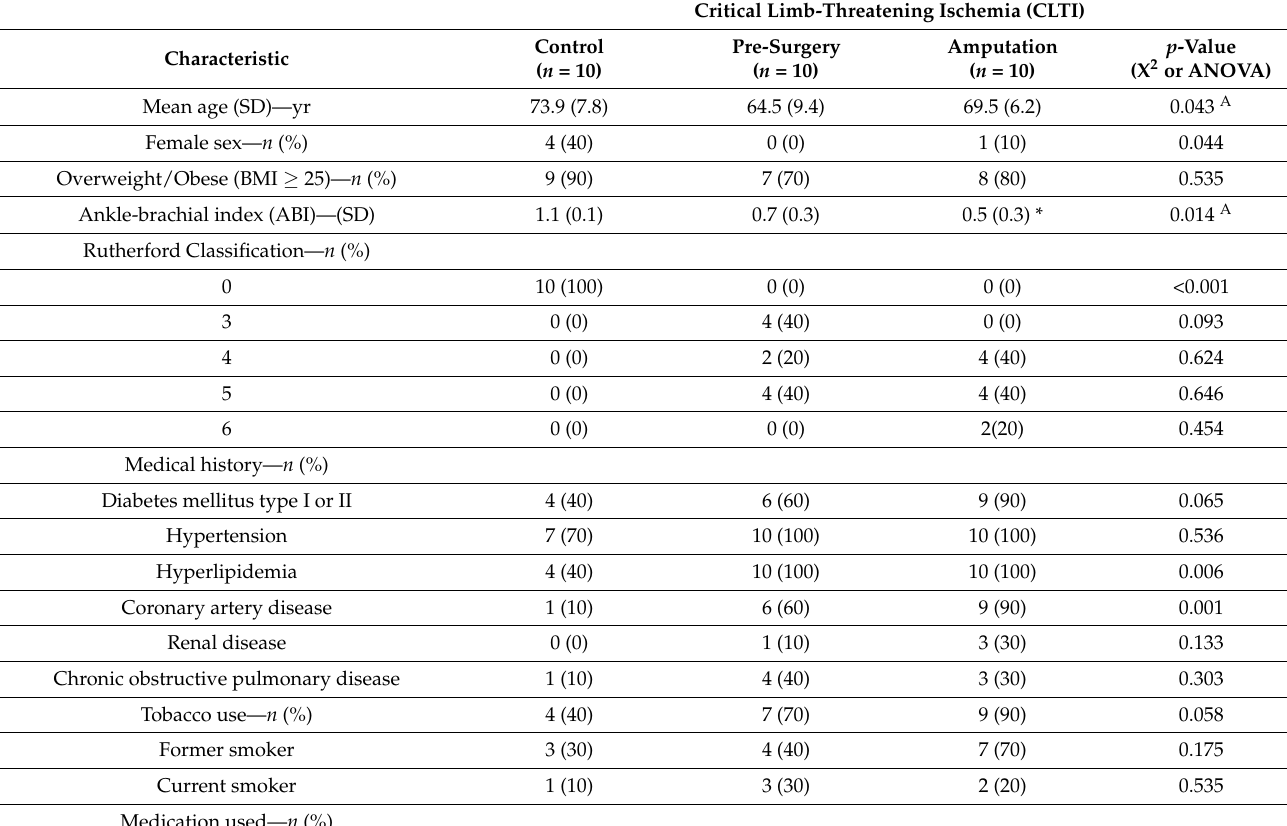
Table 1. Patient